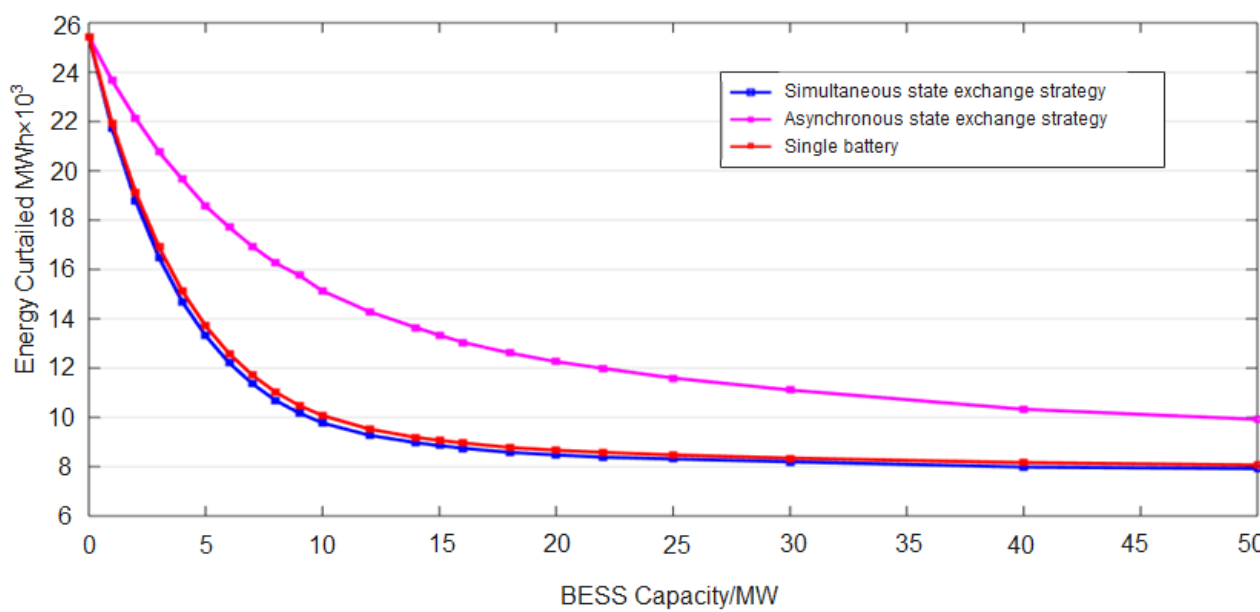
Energies 2022 , 15 , 1768 20 of 28 Figure 9. Expected injected energy deviation in various BESS capacities. Figure 9. Expected injected energy deviation in various BESS capacities.